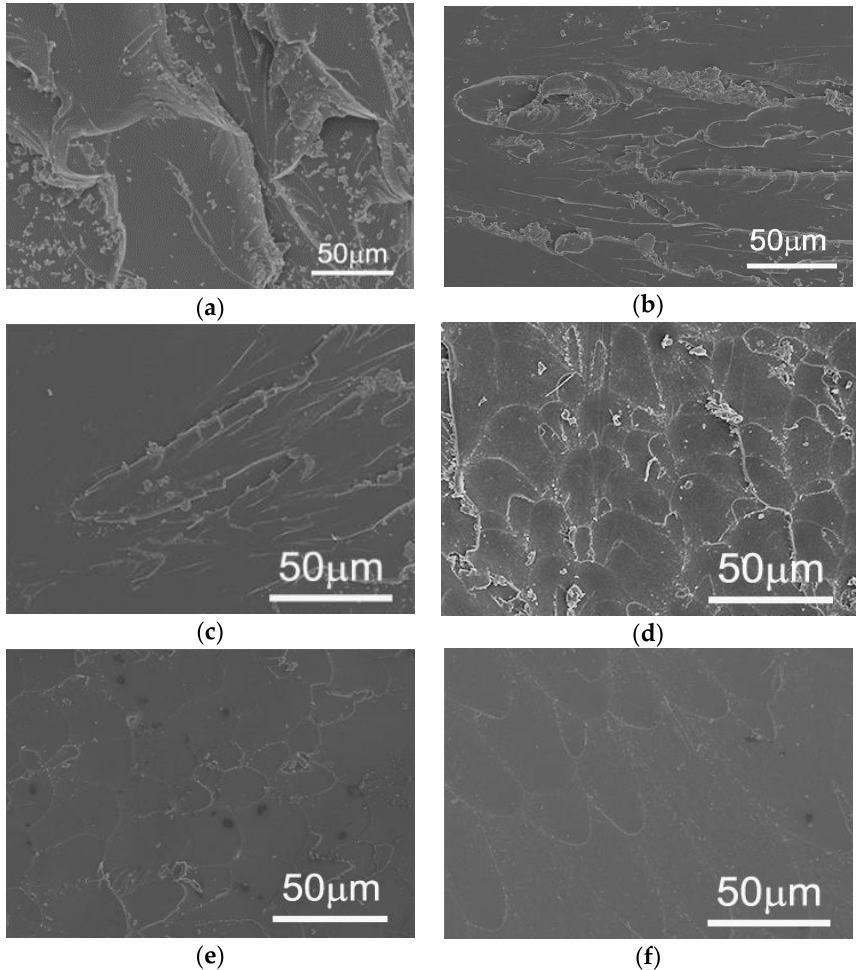
Figure 9. SEM images of epoxy resin fractured at room and cryogenic temperatures, ( a ) cured with Pro. I and fractured at room temperature, ( b ) cured with Pro. II and fractured at room temperature, ( c ) cured with Pro. III and fractured at room temperature, ( d ) cured with Pro. I and fractured at cryogenic temperature, ( e ) cured with Pro. II and fractured at cryogenic temperature, and ( f ) cured with Pro. III and fractured at cryogenic